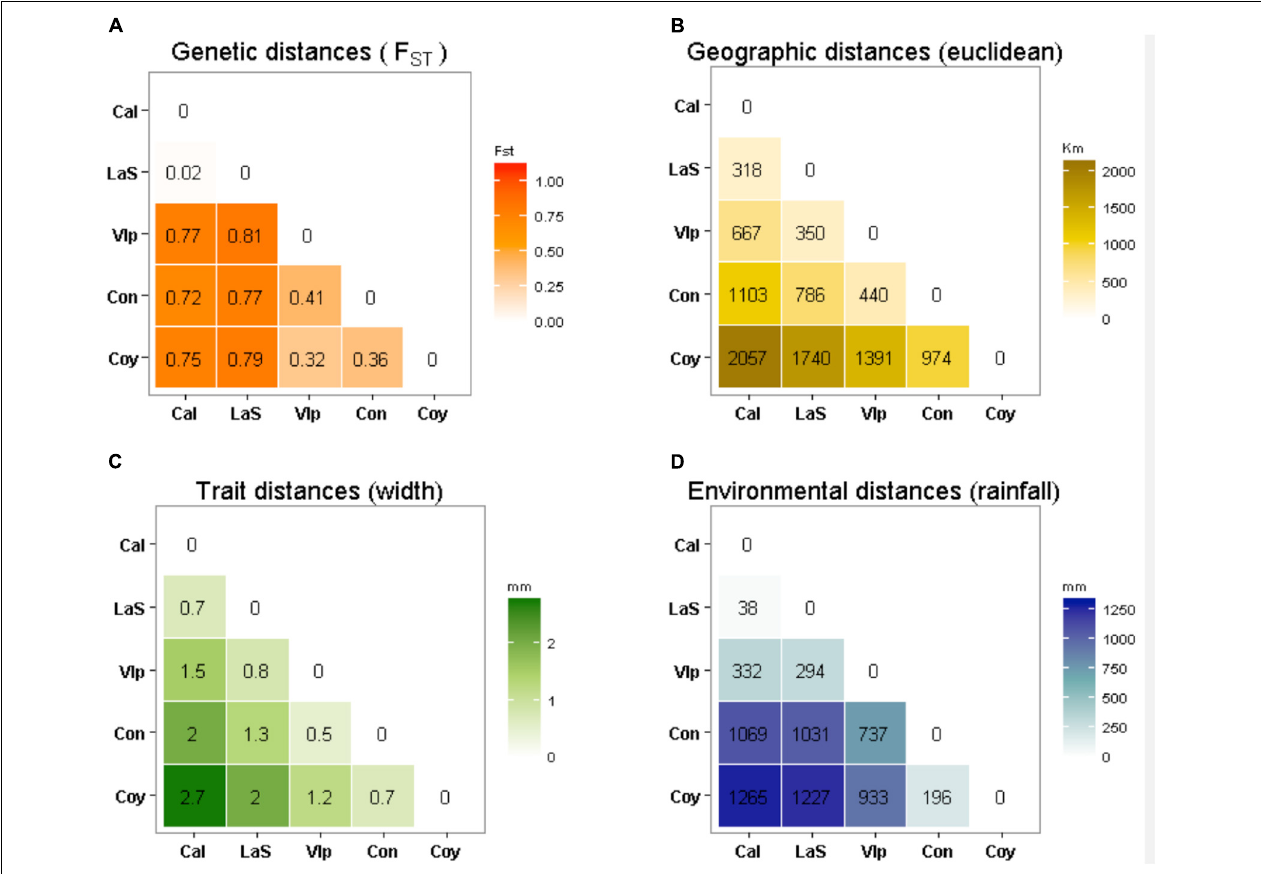
FIGURE 7 | Matrix of genetic (A) , geographic (B) , trait (C) and environmental (D) distances between T. officinale individuals from five localities (Caldera, La Serena, Valparaiso, Concepción and Coyhaique), along the latitudinal gradient. With the exception of the pairwise F ST value between Caldera and La Serena ( F ST = 0.002), all other genetic distances were statistically significant ( p <